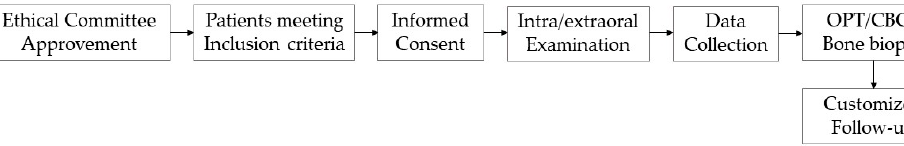
Figure 1. Study methodology.